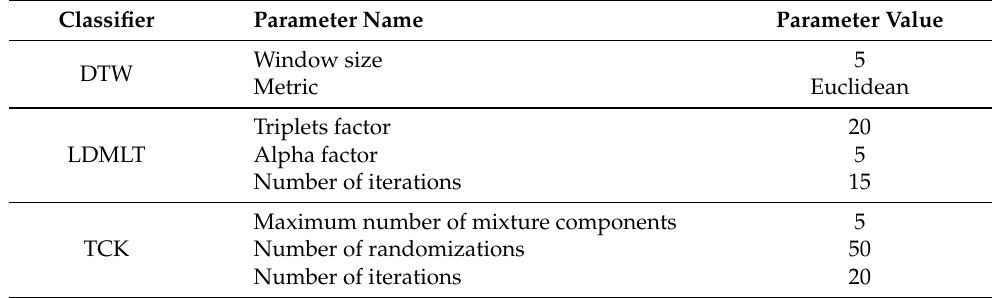
Table 4. Parameters of the